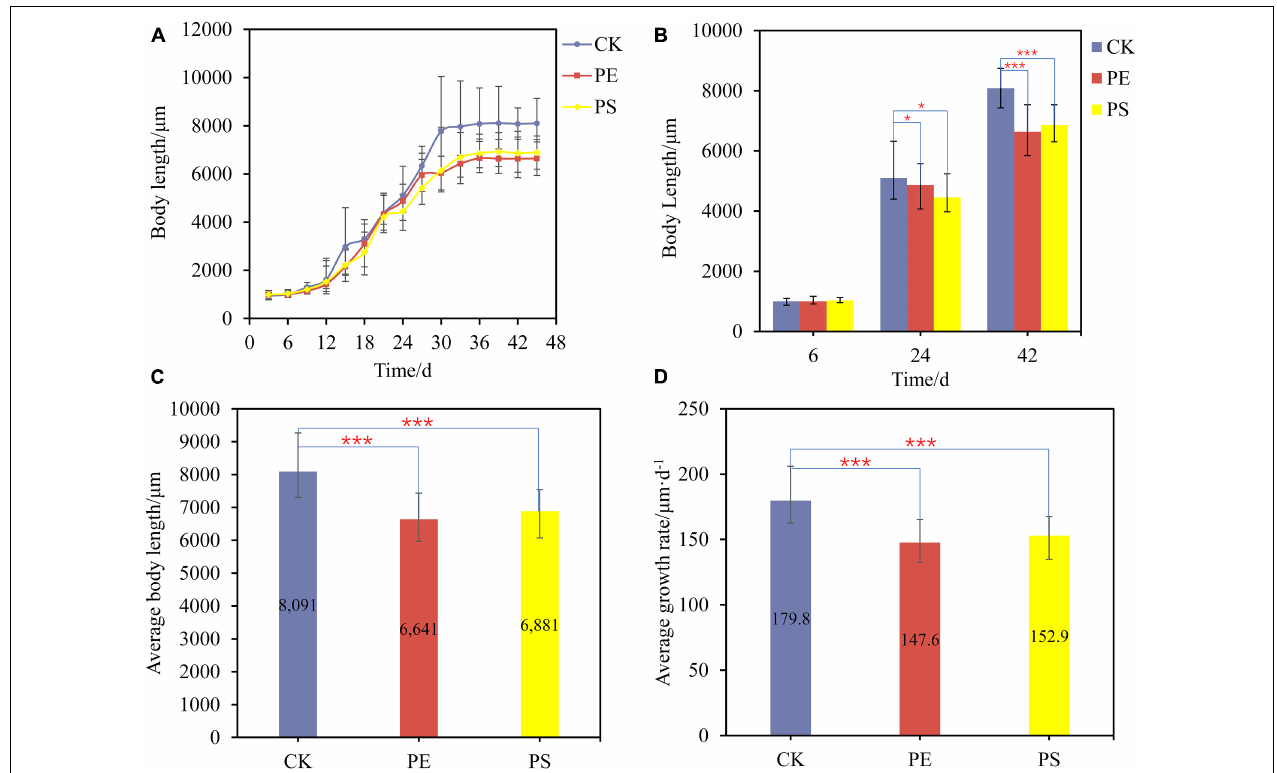
FIGURE 1 | (A) Growth curves of brine shrimps treated with different MPs; (B) body length comparison between brine shrimps measured at 6, 24, and 42 days; comparison of average body length (C) and average growth rate (D) of brine shrimps treated with different MPs. Significance levels are indicated as * p < 0.05 and *** p <